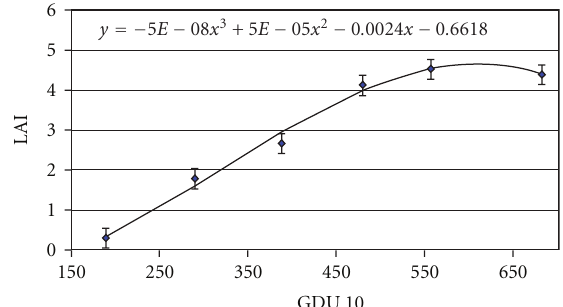
Figure 1: Leaf Area Index Development of Six Corn Hybrids (Four Glyphosate Resistant, One Glufosinate-Ammonium Resistant, and one Atrazine Resistant) Grown at Stoneville, MS in 2005 and Treated with Herbicides or Cultivated for Weed Control.